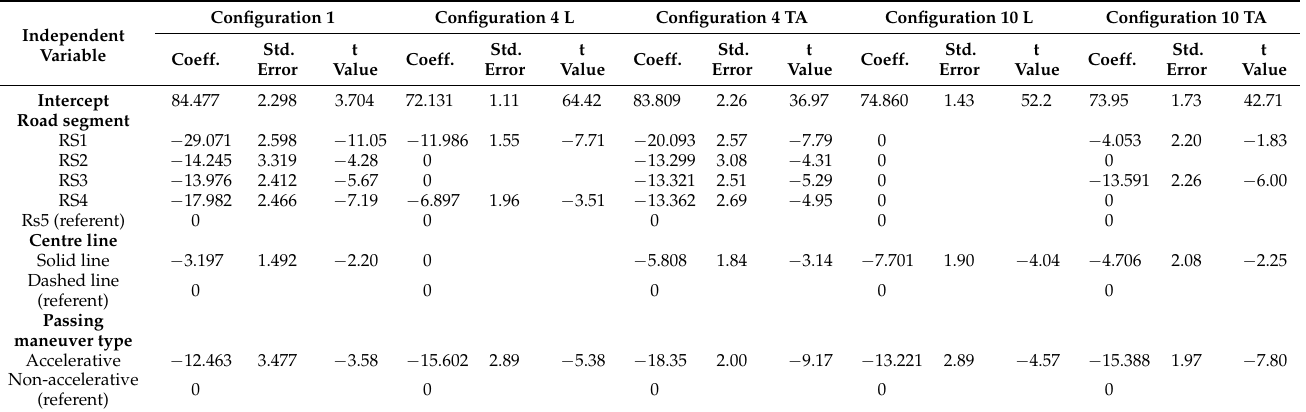
Table 5. Correlates of overtaking speed in multivariable linear regression modeling. Independent Variable